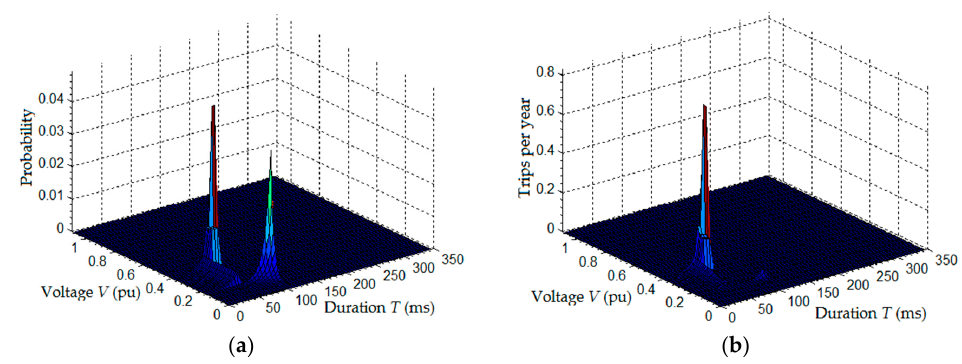
Figure 23. ( a ) Occurrence probability; and ( b ) number of expected equipment trips of various voltage–tolerance curves for contactors considering combination of probability distribution: uniform and/or exponential.